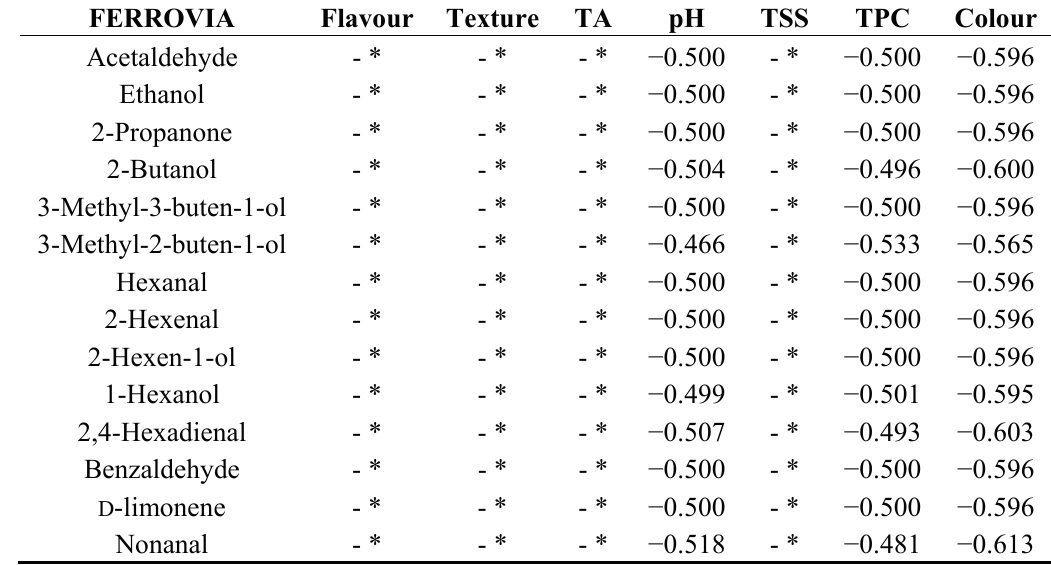
Table 5. Correlation between volatile compounds and physicochemical/sensory attributes in the Ferrovia